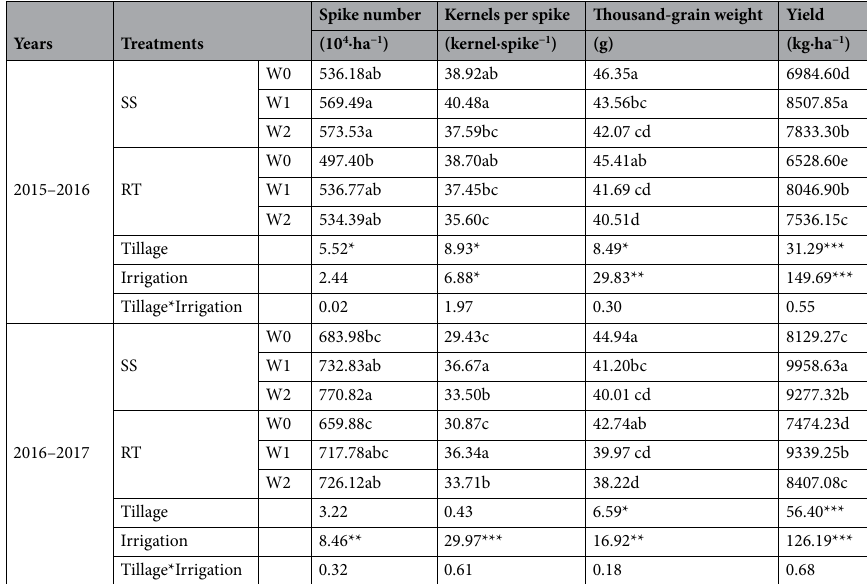
Table 1. Effects of tillage practice and irrigation regime on the yield and yield components of winter wheat in lime concretion black soil. Data followed by different lowercase letters within any column indicate that the difference is significant at the P = 0.05 level. *, **, and *** indicate significant differences at the P = 0.05, P = 0.01 and P = 0.001 levels, respectively. The same as below.